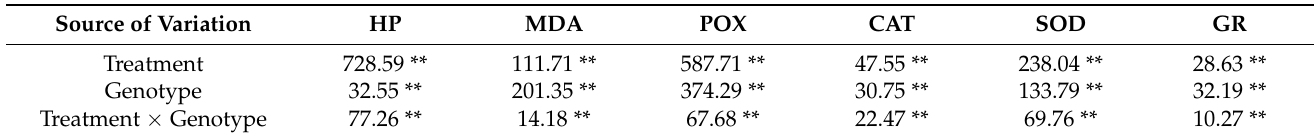
Table 1. Analysis of variance (ANOVA) F values for biochemical traits between lentil genotypes, Cd treatments, and their interaction.